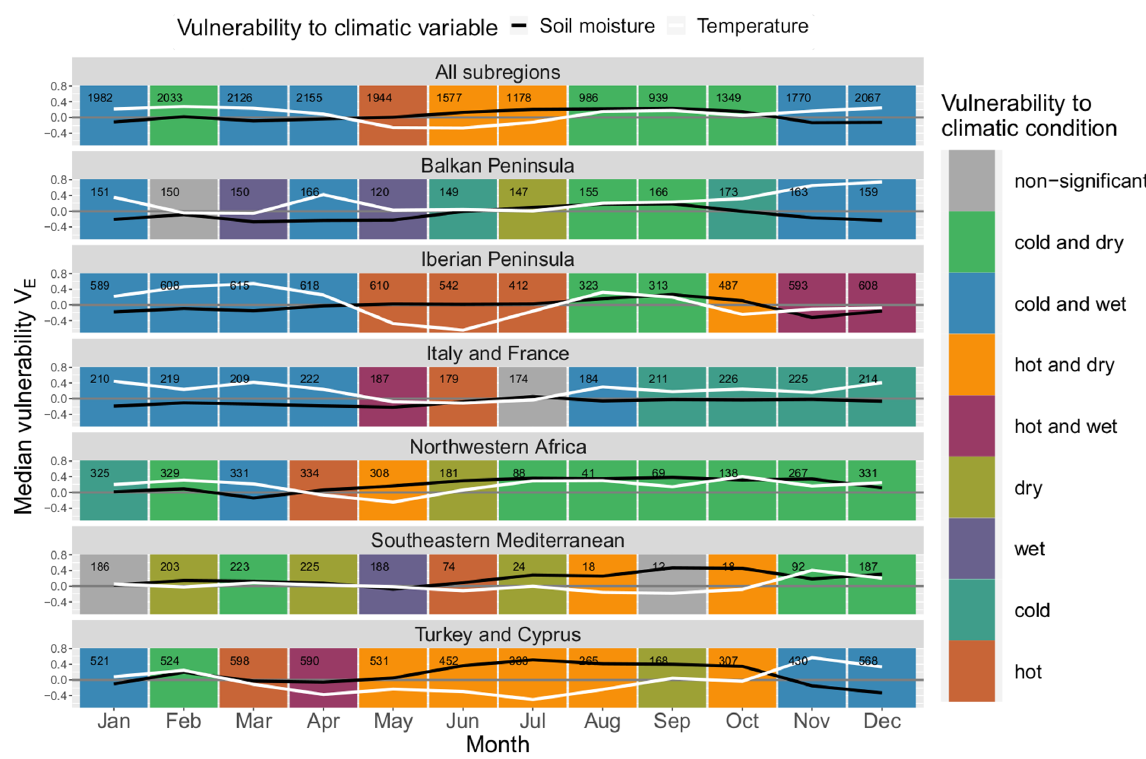
Figure 6. Median monthly ecosystem vulnerability per subregion: vulnerability to temperature (ERA5-Land) is shown in white, and vulnera- bility to soil moisture (ESA CCI) is shown in black for each month of the year (columns) for each land cover (rows). Months with statistically significant deviation in climatic drivers during non-hazardous and hazardous ecosystem conditions according to the Mann–Whitney U test based on a significance level α = 0 . 05 are shown in colour (see legend); all other months are shown in grey. The number of grid points in which an event has occurred in this month and subregion within the period 1999–2019 is shown in the upper left corner of each panel.